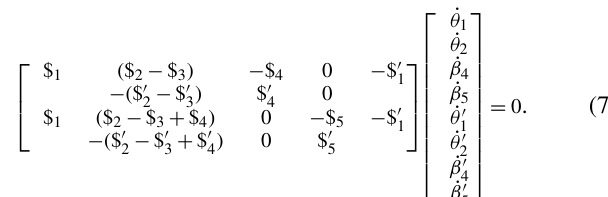
Figure 2. Structure of novel SLE-Pa leg in case